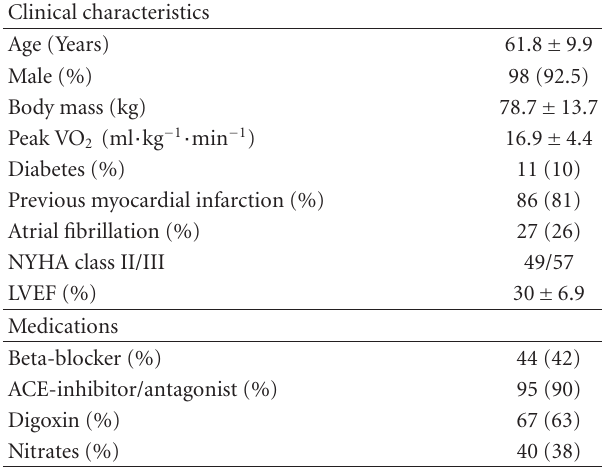
Table 3: Exercise program parameters and change in primary outcome measures in the 4